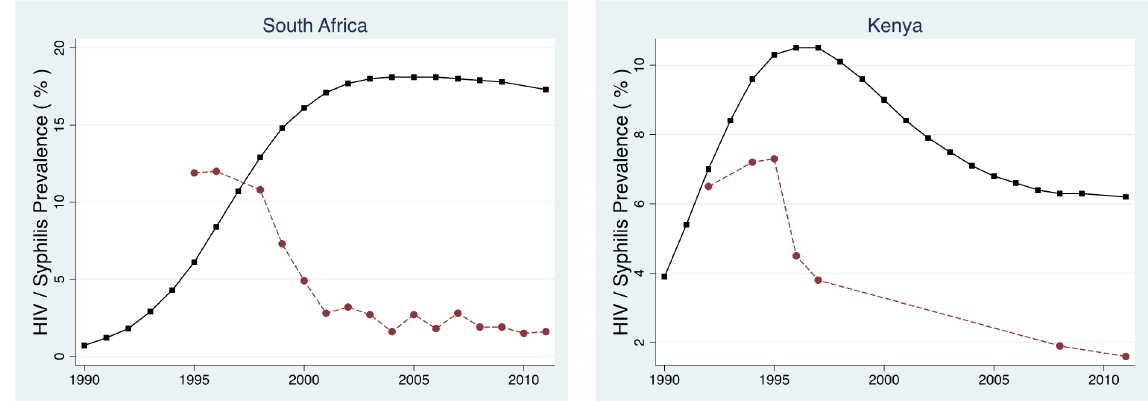
Figure 4. Prevalence of antenatal syphilis (red circles) and HIV (black squares) in South Africa and Kenya between 1990 and 2012.